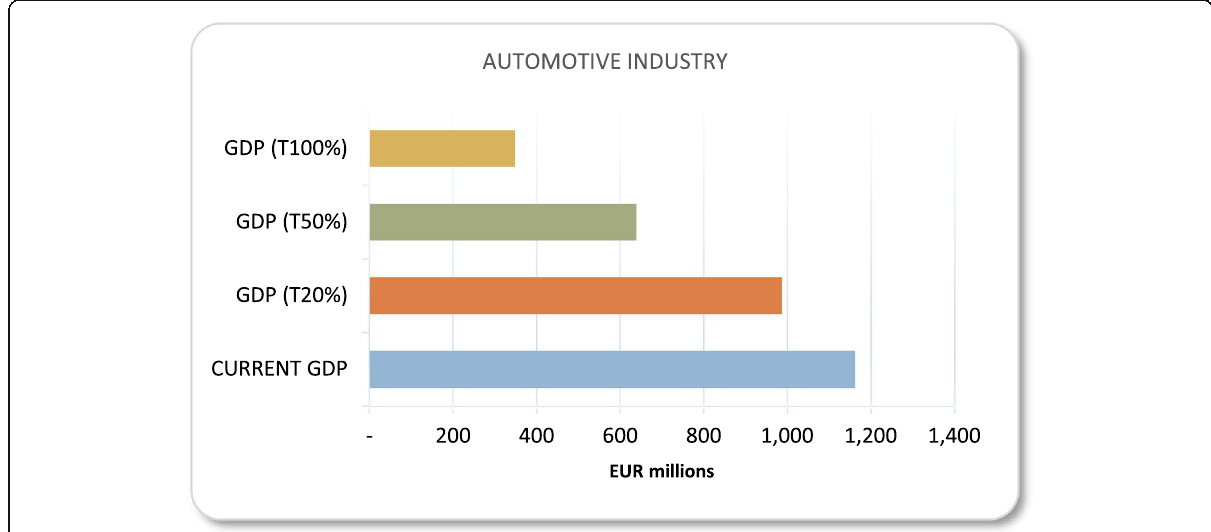
Fig. 6 Automotive Industry Spanish GDP